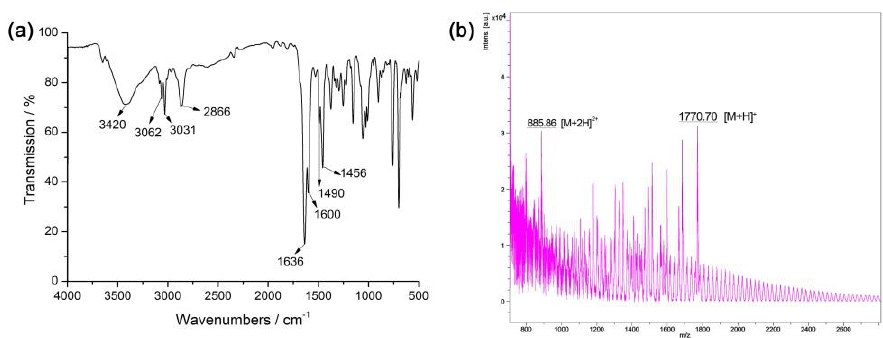
Figure 1. ( a ) FT−IR and ( b ) MALDI−TOF−MS spectra obtained for the chiral POC.